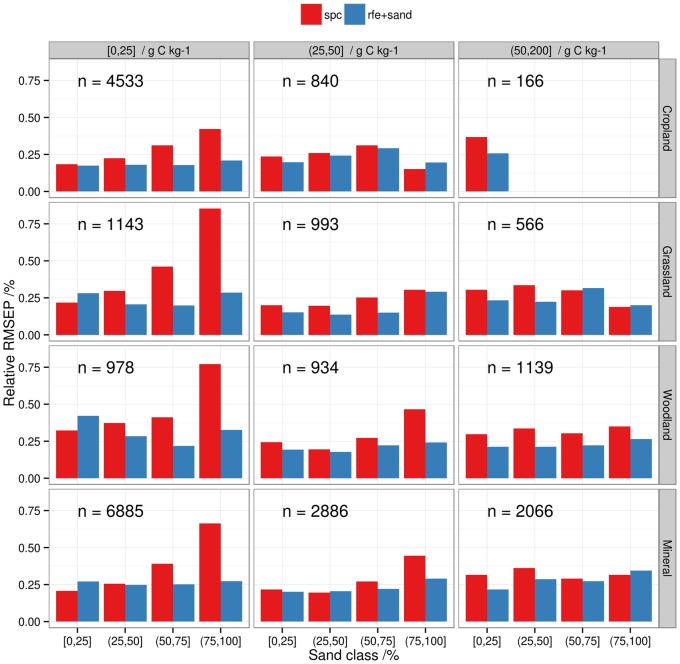
Relative Root Mean Square Error of Prediction (RMSEP) per land cover, for arbitrary classes of SOC and sand content.The sand classes are 0–25%, 25–50%, 50–75%, 75–100% and the SOC classes are 0–25 g C kg−1, 25–50 g C kg−1, 50–200 g C kg−1. The relative RMSEP is the RMSEP divided by the mean of observed SOC values of models developed with (red bars) and without auxiliary predictors (blue bars). Each panel regroups mineral samples of a given SOC interval and land cover type. The number of training samples (n) for each class of SOC content is given in each panel.